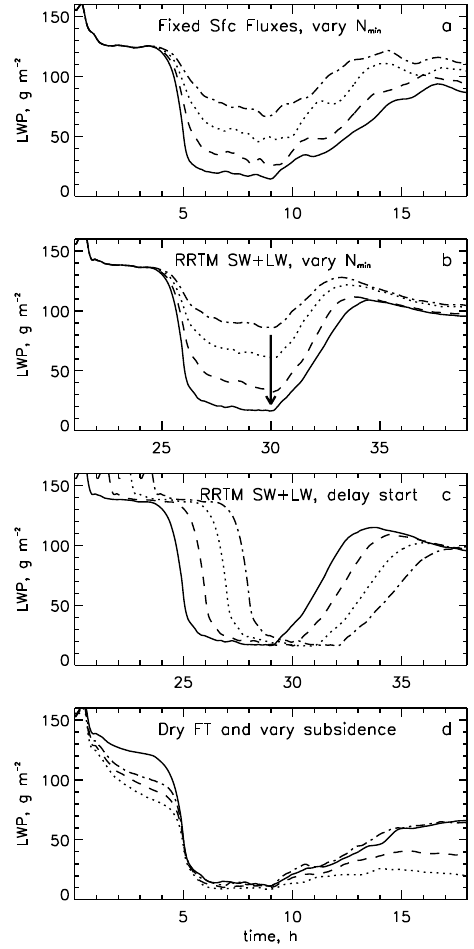
Figure 6. Tests of robustness of LWP recovery. (a) Control case but with fixed surface fluxes and no winds. Line types as in Fig. 1; (b) RRTM (shortwave and long wave) and start time of 21:00LT. Line types as in Fig. 1. The arrow points to sunrise at 06:00LT ( t = 30h); (c) as in (b) but with start times staggered by 1h between 20:00 and 23:00LT; (d) control case (solid line); dry air aloft (dashed line), dry air aloft and divergence increased to 5 × 10 − 6 s − 1 (dotted line), and dry air aloft but divergence de- creased to 1 × 10 − 6 s − 1 (dash-dotted line). The drier air aloft is cal- culated according to q v = q v , 0 − 3gkg − 1 [1 − exp (( 795 − z)/ 500 ) ] with q v , 0 = 3gkg − 1 rather than q v , 0 = 5gkg − 1 as in the control case. (Terms in the exponent are in meters.) The precipitable water at t = 0 is 10.0mm compared to 11.7mm for the standard profile. In (c) and (d) the minimum N = 5mg − 1 .